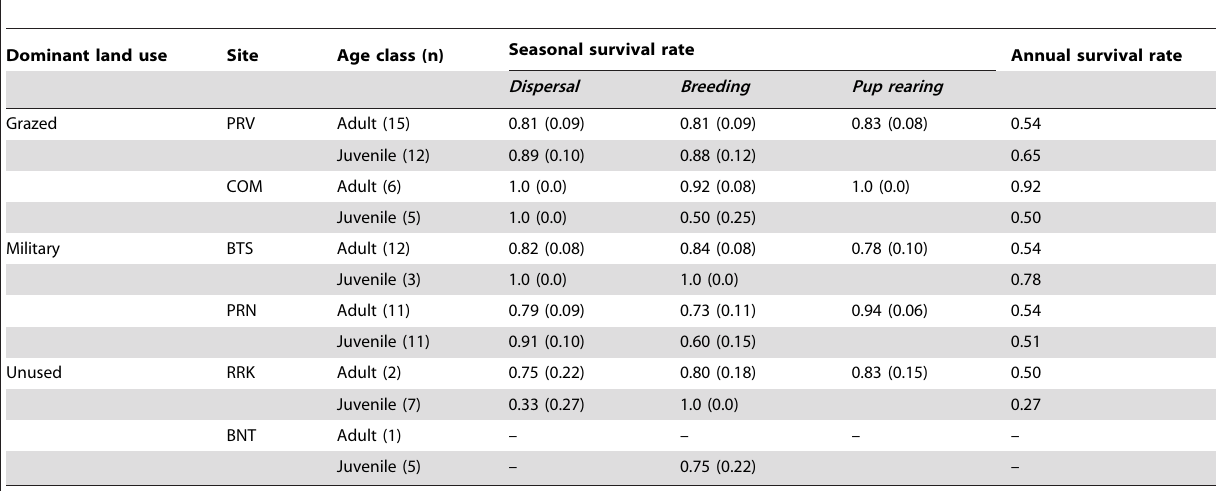
Table 3. Estimates of survival rates ( 6 SE) for adult and juvenile swift foxes on 6 study sites located in southeastern Colorado, USA,